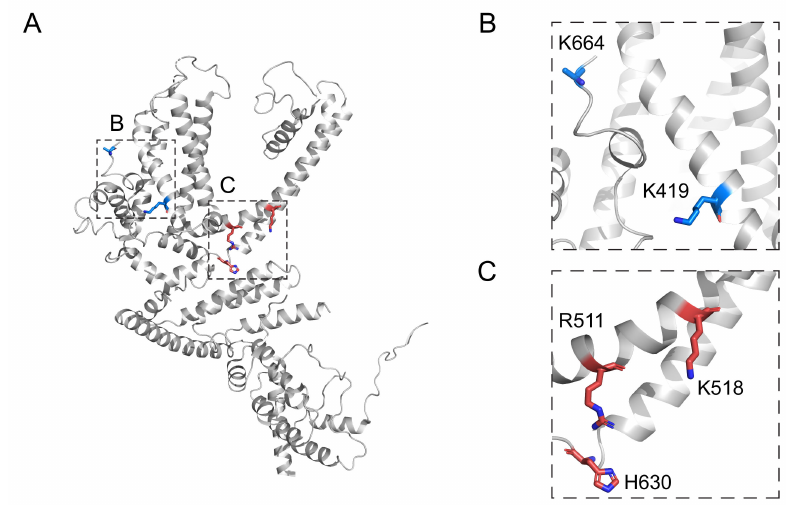
Figure 5. Putative binding pocket for PIP 2 in TRPC4 channels. ( A ) Two binding pockets shown in one subunit of the channel. ( B ) First binding pocket consists of K664 and K419. ( C ) Second binding pocket consists of R551, K518, and